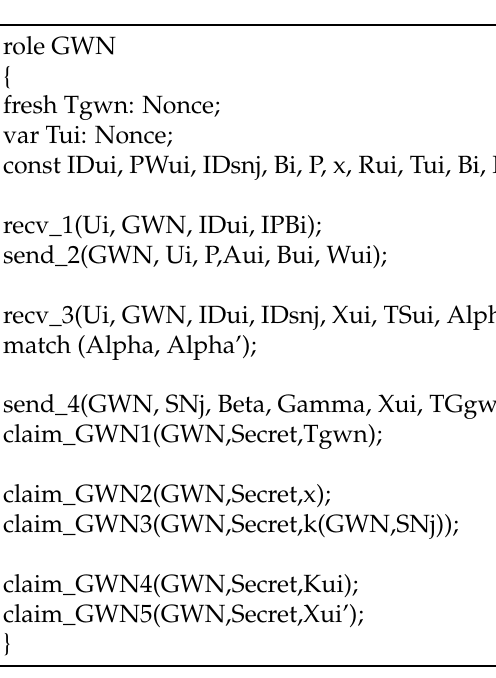
Table 12. Specification of the gateway node’s role in